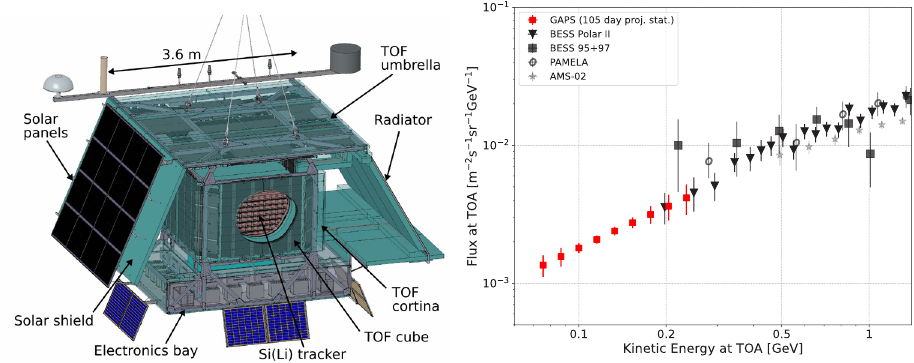
Figure 1. Left panel : A schematic view of the GAPS detector. Right panel : The GAPS sensitivity for cosmic antiproton spectrum (red) at the top of the atmosphere is shown with the statistics expected from three 35-day flights [7]. Data from BESS (1995 and ‘97 [12]), BESS Polar II [13], PAMELA (2006 [14]), and AMS-02 (2011 18 [15, 16]) are also −